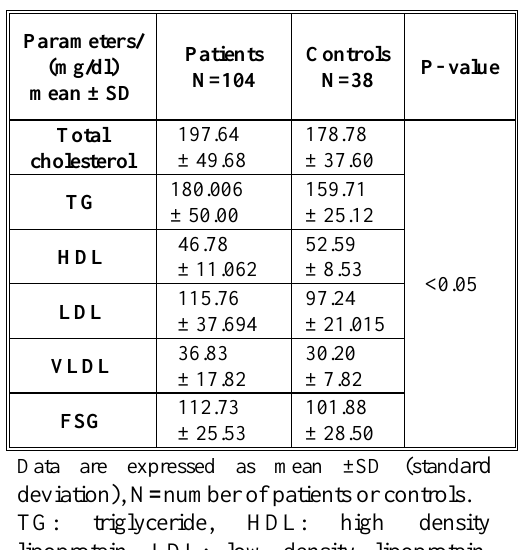
Table (1): Serum lipid profile and Fasting serum glucose in gallstone patients and controls.